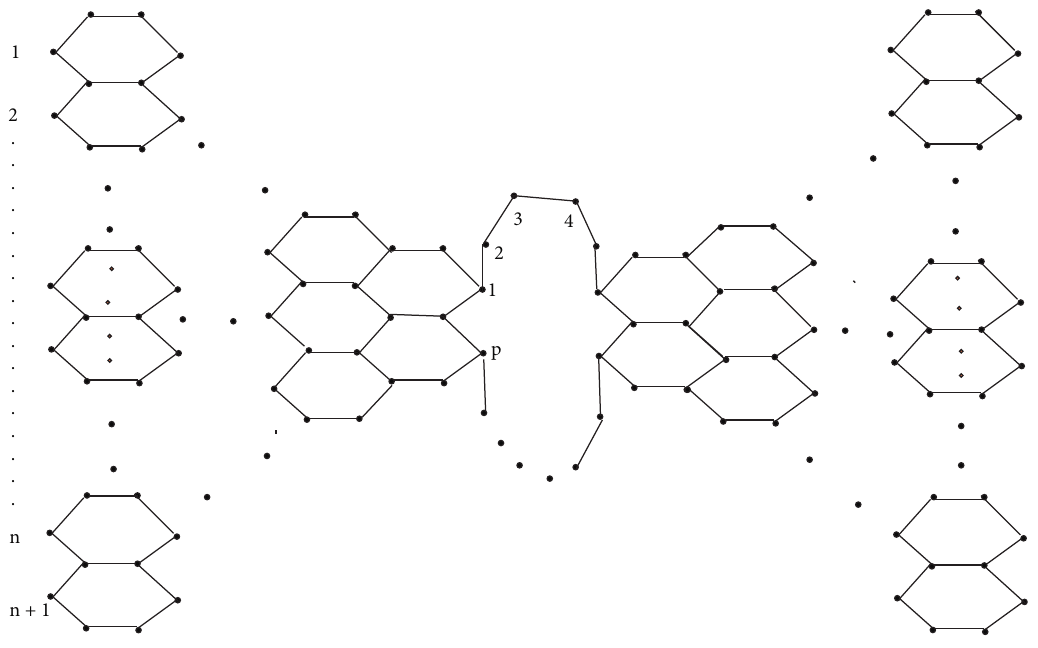
Figure 4: Generalized hourglass carbon nanocone HGSCNC ( n, p ) .